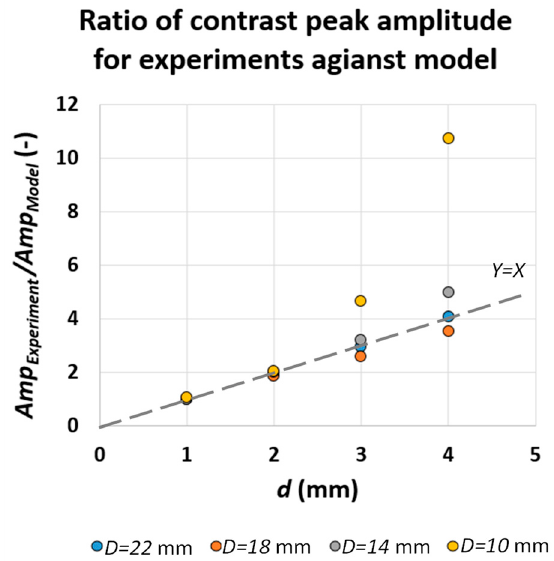
Figure 13. The ratio of contrast peak amplitude for experiments against model.